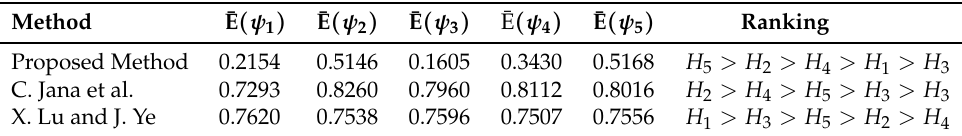
Table 4. Comparison with some other existing